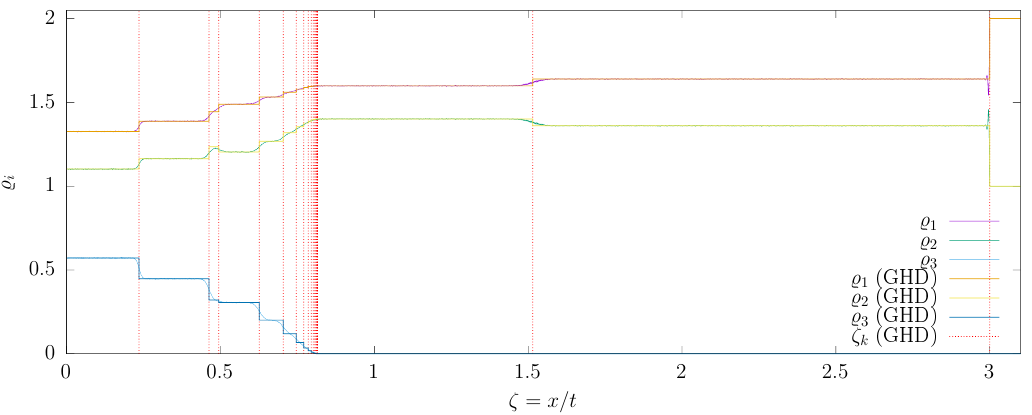
(1) Figure 6: Same as Fig. 5 but for the T dynamics. We again have an infinite series l =3 0 . 81586 . The last step of narrow plateaux which accumulate in the vicinity of ζ (cid:39) is located at ζ = 3 , beyond this point the system is in the vacuum state ( i.e (cid:37) 1 = 2 , (cid:37) 2 = 1 and (cid:37) 3 = 0 ). Notice the density spike just before ζ = 3 . The soliton speeds and densities in the three four plateaux are displayed in Fig.